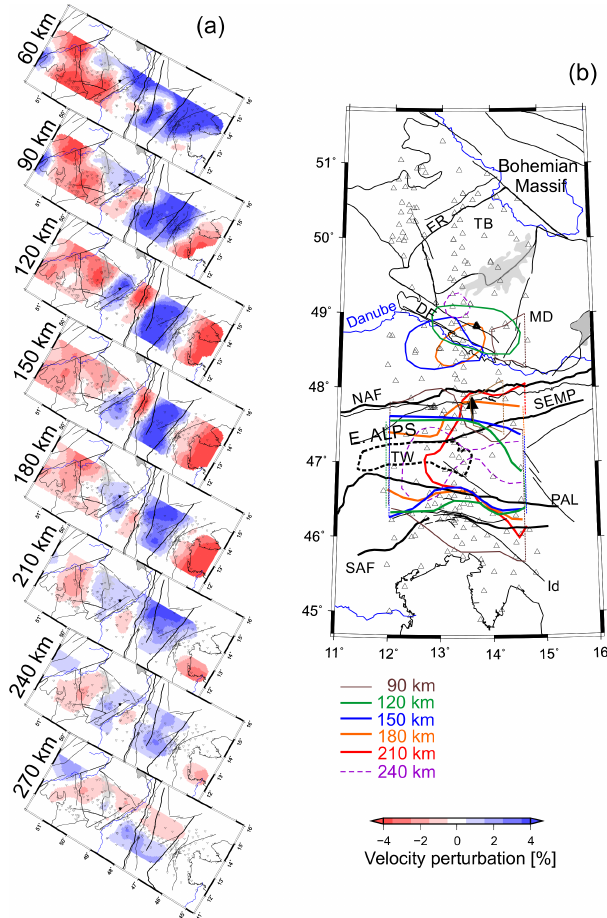
Figure 2. Depth slices through the new EASI-AA velocity perturba- tion model (a) along with depth contours of the 1.5% perturbations in map view (b) . The arrow marks the northward dip of the cen- tral and eastern part of the eastern Alpine heterogeneity. Labels of main tectonic faults and units: PAL – Periadriatic Lineament, NAF – Northern Alpine Front, SAF – Southern Alpine Front, SEMP – Salzach–Ennstal–Mariazell–Puchberg fault, TW – Tauern Window (dashed), DF – Danube fault, Id – Idria fault, MD – Moldanubian and TB – Teplá–Barrandian units of the Bohemian Massif (BM), ER – Eger